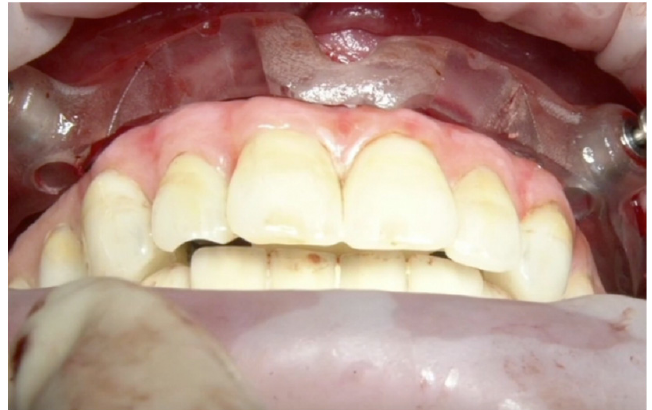
Figure 12. Base-portion used to guide for the immediate loading. It allows for the temporary